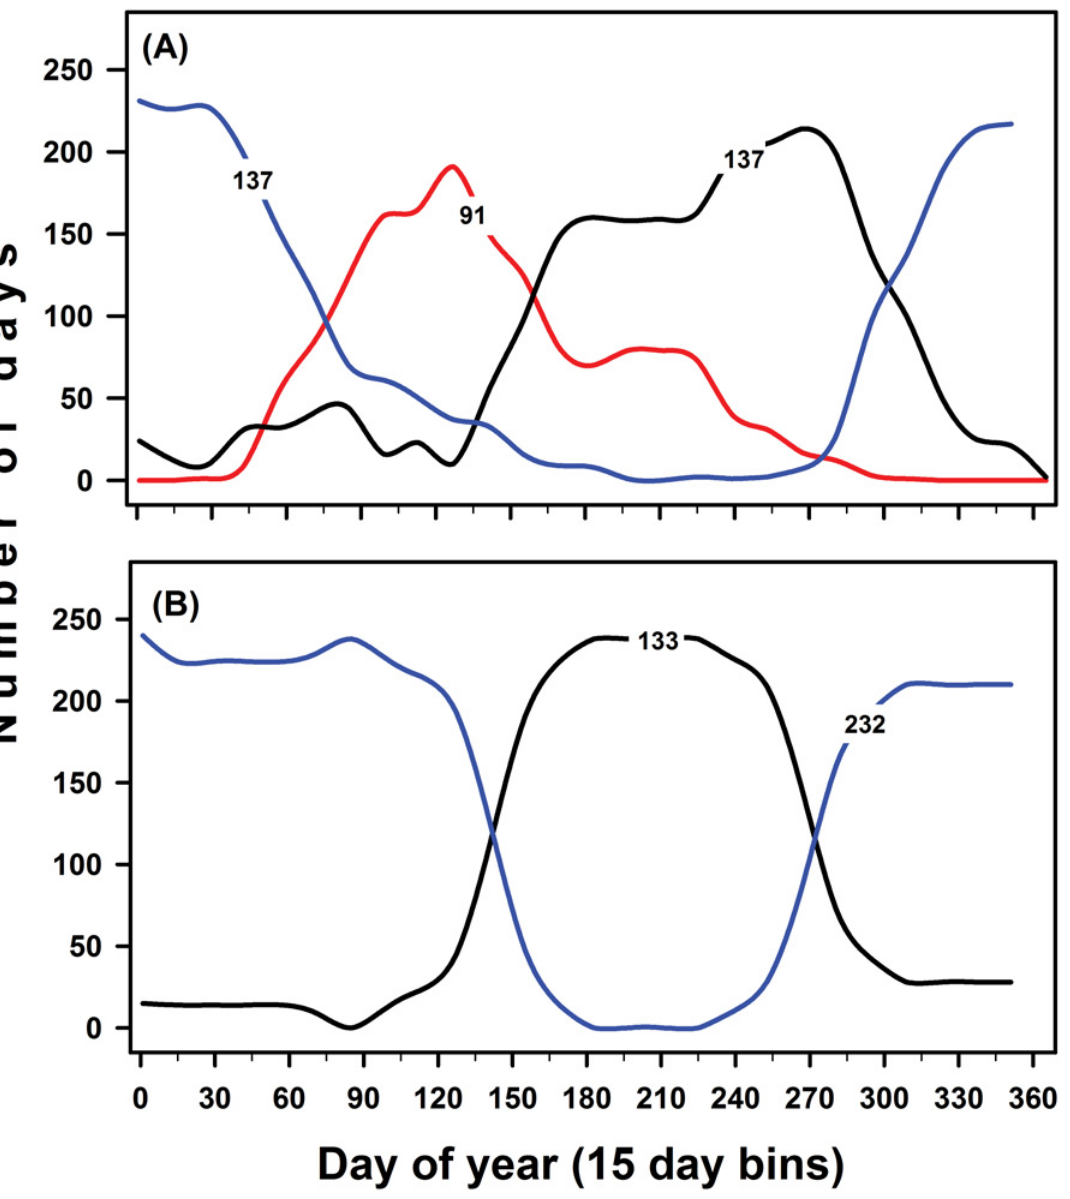
Figure 2. Seasonal timing of candidate models representing seasons. Models were developed using cluster analyses of four daily fire-weather variables over 13 years (1997 – 2009). Panels include (A) results of the selected model with 3 clusters (the “ representative model ” ), and (B) results based on dry and wet seasons defined by the CRA reference model. For each panel histograms for different colors are coded as follows: black = histogram of cluster appearing to represent the wet season, blue = cluster appearing to represent the dry season, and red = cluster appearing to represent the peak fire season. Histograms use 15 day bins. Numbers detail average number of days per year found for each